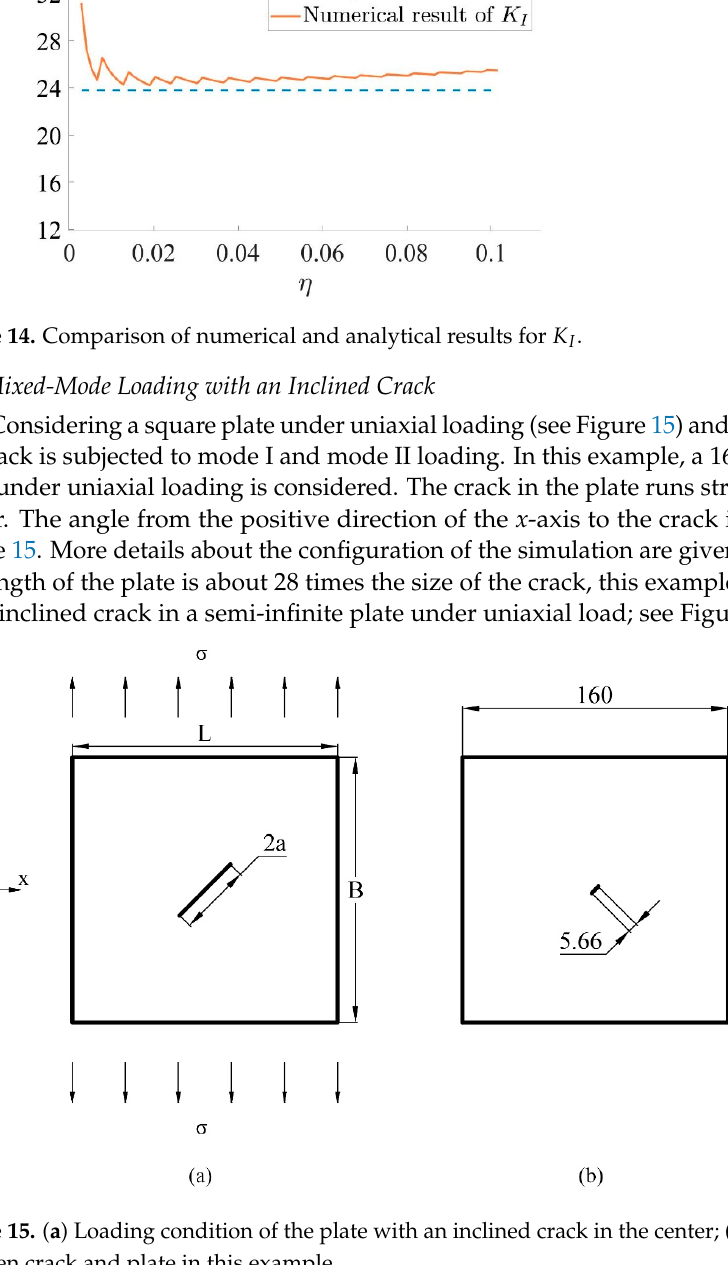
Figure 16. ( a ) Global mesh (in this view, the size of the largest element is 8 mm × 8 mm); ( b ) Mesh from the view of the 2nd-level refinement domain (in this view, the size of the largest element is 1 mm × 1 mm); ( c ) Comparison between the elements from the 5th-level refinement domain with the elements from the 4th-level refinement domain (in this view, the size of the largest element is 0.0625 mm × 0.0625 mm).